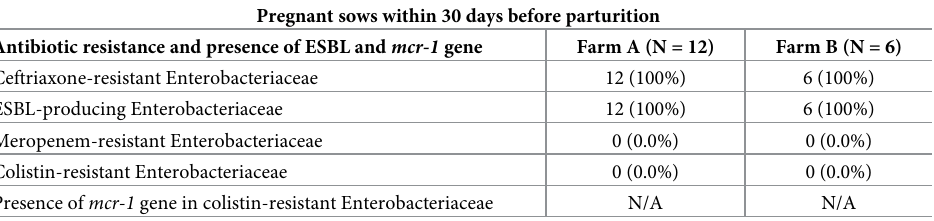
Table 1. Prevalence of resistance to ceftriaxone, meropenem, or colistin; of ESBL production; and, of the presence of the mcr-1 gene in Enterobacteriaceae isolated from pregnant